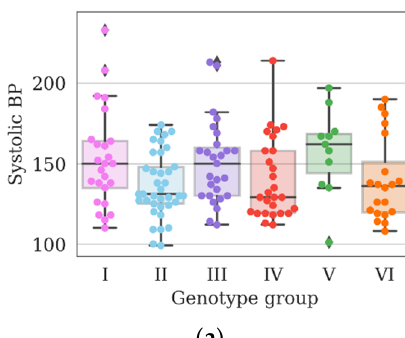
Figure 5. The distribution of study participants by clusters depending on the combination of geno- types in the population of residents of the Nizhny Novgorod region. A cluster was defined as a group of at least 10 participants.